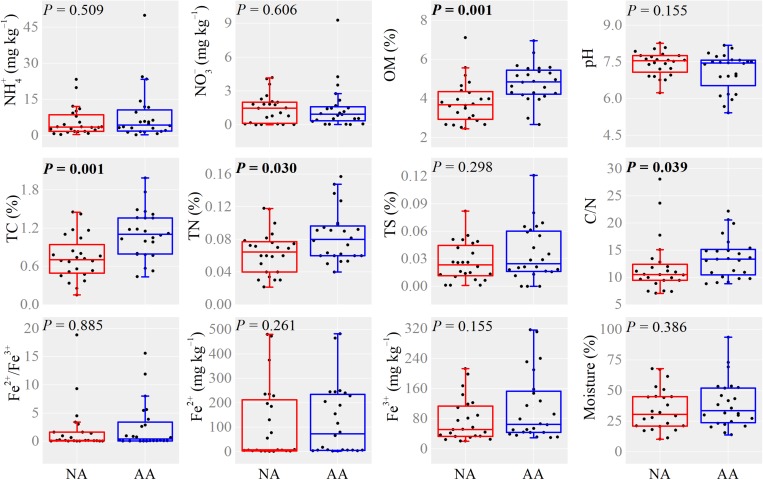
Boxplots of soil properties in NA and AA. Single dot represents the average value in each sampling elevation. P-values in bold indicate significant differences at 0.05 level based on Mann–Whitney U-test.